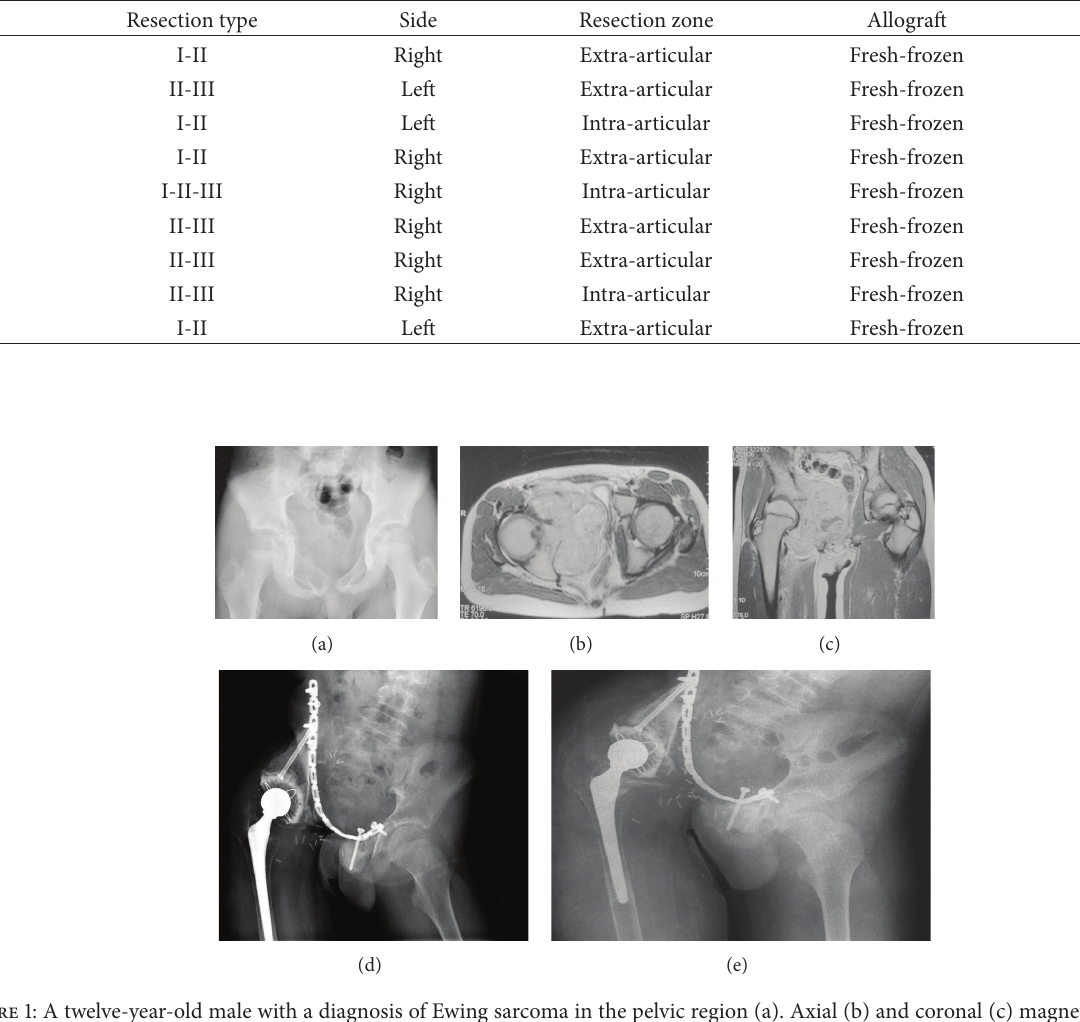
Table 2: Type of resection and fixation.